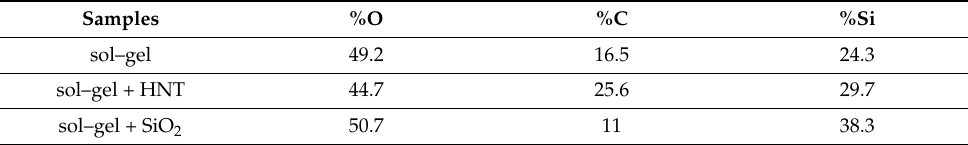
Table 1. Atomic percentage determined by XPS for sol–gel, sol–gel-HNT, and sol–gel + SiO 2